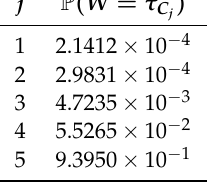
Figure 2. Plots of the joint probabilities P ( W ≥ n , W = τ C Table 7. The stopping probabilities P ( W = τ C